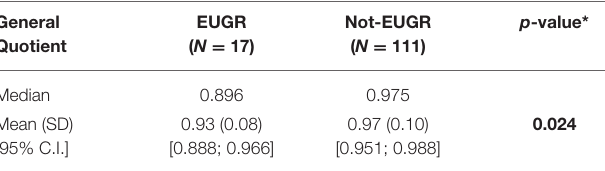
TABLE 6 | Differences in General Quotient between longitudinal post-loss EUGR and not-EUGR populations regarding HC. General Quotient